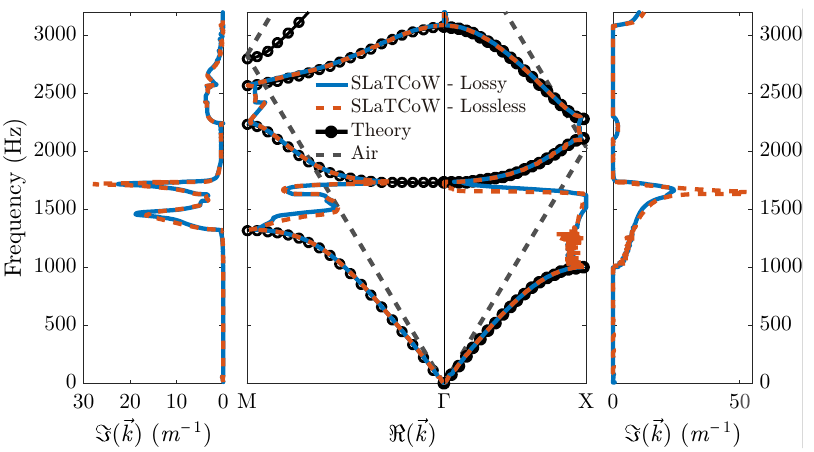
Figure 4. Complex dispersion relation for a periodic resonant system formed by QWRs. Numerical simulations using an infinite structure and solving the corresponding eigenvalue problem in FEM are compared to the results obtained applying SLatCoW from numerical data using a finite